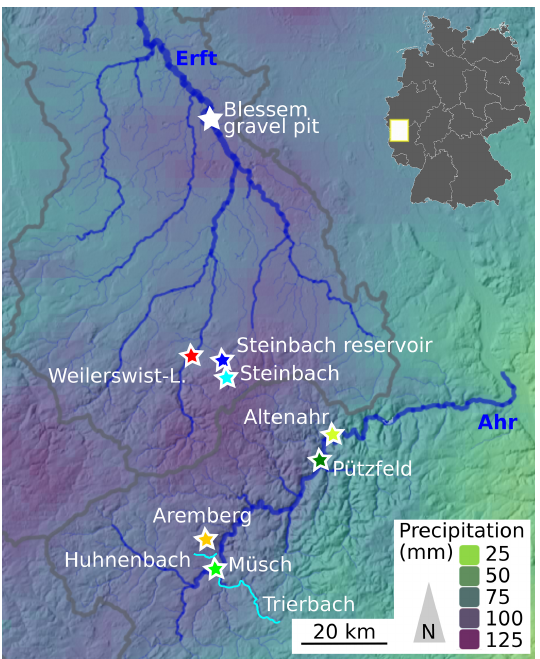
Figure 1. Map of the affected area with 3d precipitation accumu- lated for 12–15 July 2021 from RADOLAN data (Radargestützte Niederschlagsanalyse und -vorhersage; CDC, 2022). Stars indicate locations of pictures of other figures in this article. Light-blue lines depict rivers of special interest mentioned in the text. Background map shows two of the most affected river systems, Erft and Ahr (line width indicating stream order), on top of a hillshade and slope map. Inset shows the location of the map within